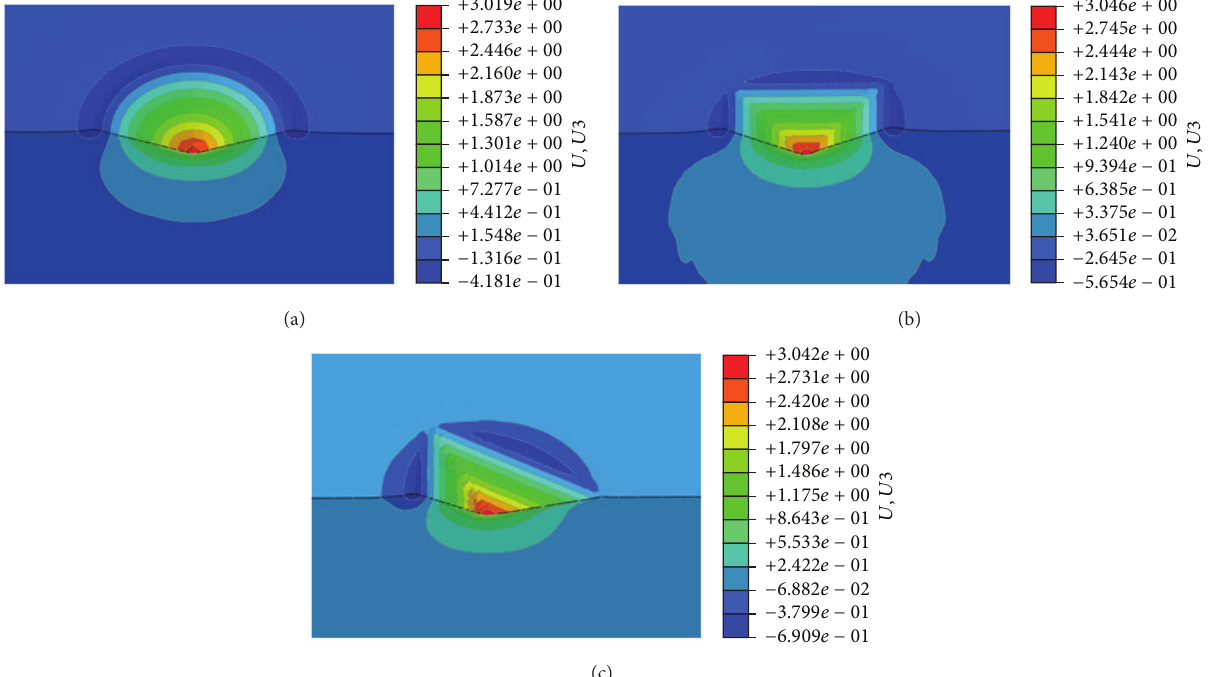
Figure 2: Displacement fields at indentation depth of 3 𝜇 m for conical indenter (a), Vickers indenter (b), and Berkovich indenter (c). Only half of each model is shown. Note that the negative values of displacement ( U3 ) indicate pileup of the